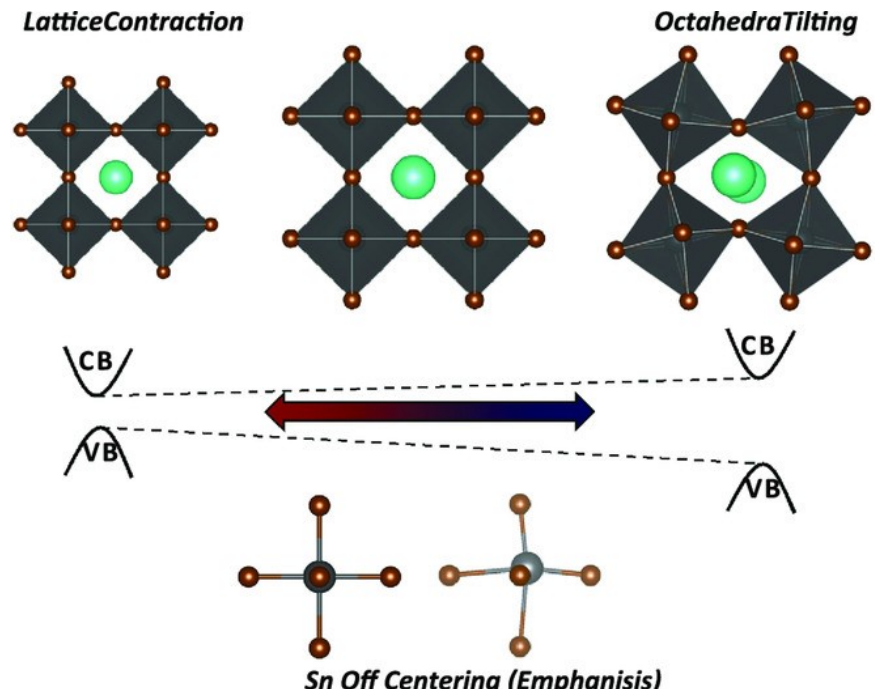
Figure 3. Perovskite lattice distortion. Reproduced from [31] under Creative Commons CC By license. Copyright 2018, Wiley-VCH.